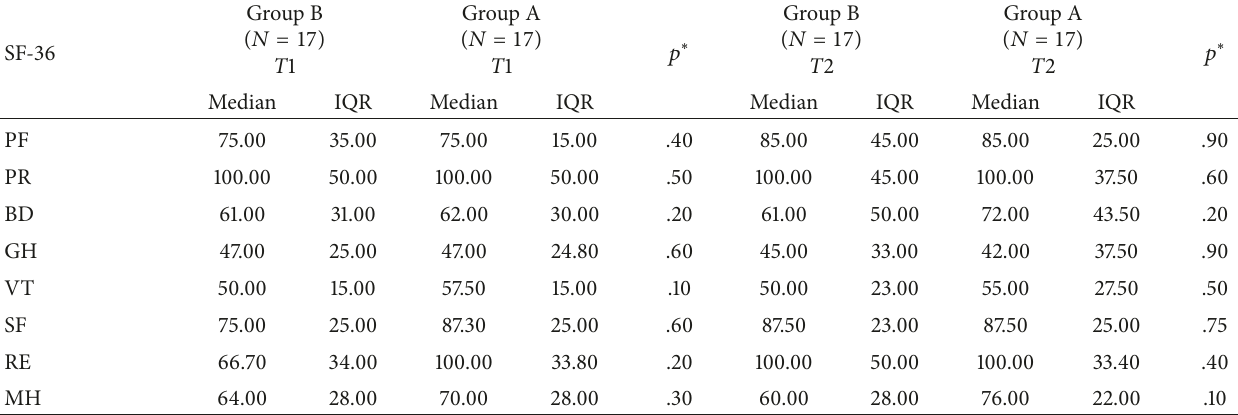
Table 2: Quality of life: comparison between groups at T 1 (end of treatment) and T 2 (follow-up) for SF-36 and subscales.